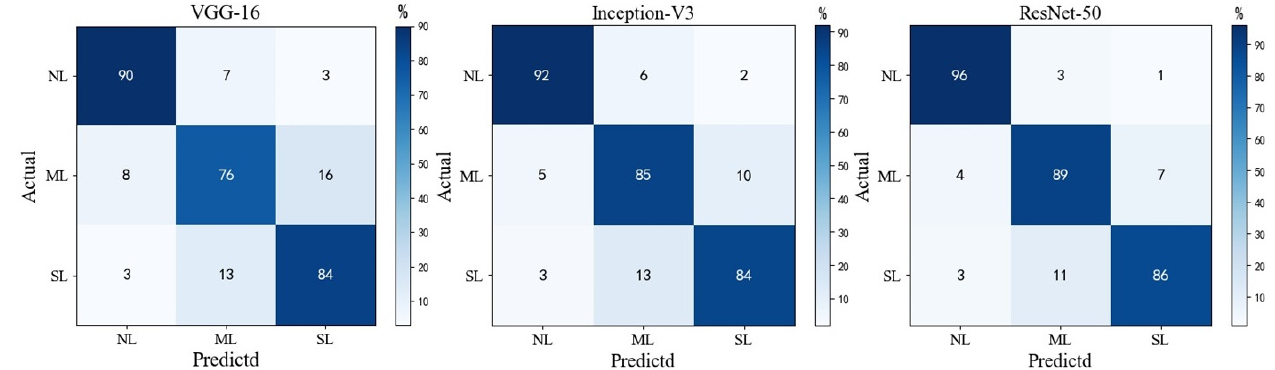
Figure 13. The confusion matrices of the three algorithms through RGB images. Types of lodging extents: NL is non-lodging, ML is moderate lodging, SL is severe lodging.